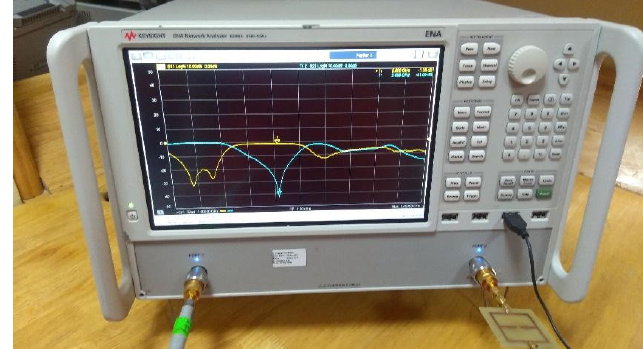
Figure 10. Photo of the considered experimental setup.